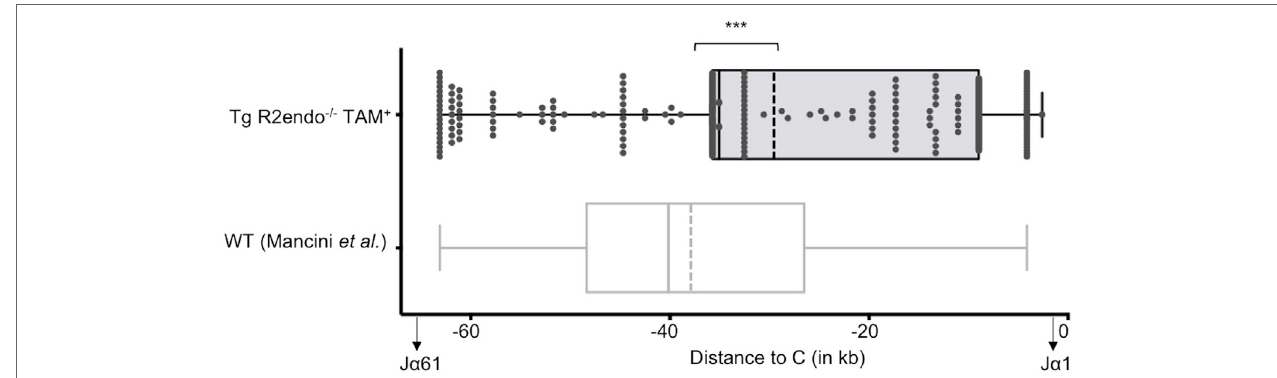
FigUre 3 | The T cell receptor (TCR) J α repertoires of 4-hydroxytamoxifen (TAM)-induced Tg endoR2 − / − and wild-type (WT) mice are significantly different. Tg-endoR2 − / − mice (TgendoR2 − / − ) were fed with normal TAM ( + ) food during 4 weeks before analysis. PCR and HTS sequencing of TCR α rearrangements were performed and represented as follow: each dot is a rearrangement, and the x -axis represent the distance between the J α used in the rearrangement and the constant (C) region. The doted vertical bars represent the average distances to (C) of the J α used in rearrangement in TAM-induced Tg endoR2 − / − (upper boxplot) and WT mice (bottom boxplot, from Mancini et al.). *** stands for a p -value < 10 − 4